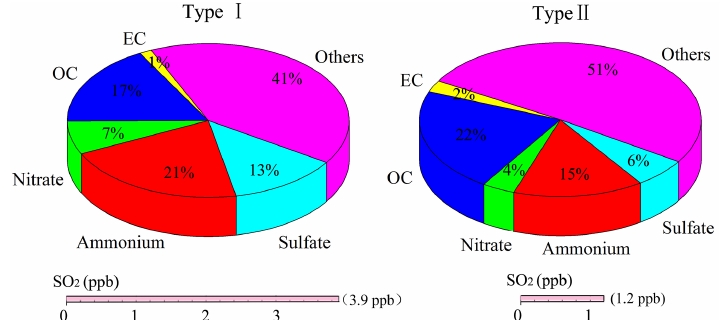
Figure 6. The average chemical composition of PM 2 . 5 and SO 2 concentration in a more polluted continental air mass (Type I) and a relatively cleaner continental air mass (Type II) on NPF